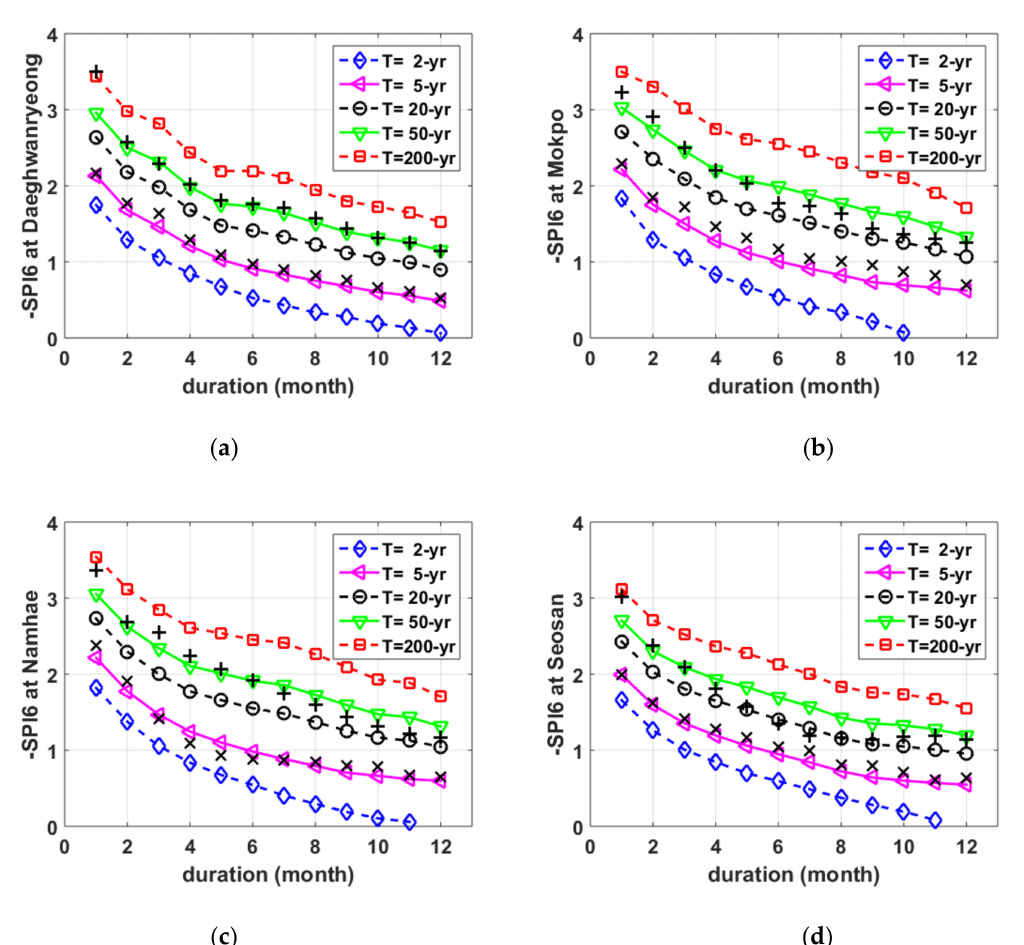
Figure 4. SDF curves using partial duration series at ( a ) Daeghwanryeong, ( b ) Mokpo, ( c ) Namhae, and ( d ) Seosan. In Figure 4, + is the drought index observed to be the most severe during the 37-year period for a specific duration, and x is the drought index observed to be the seventh most